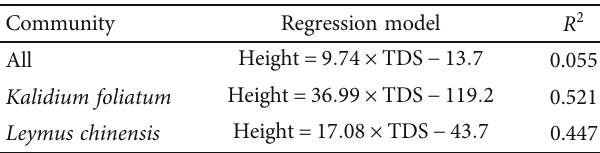
Table 3: Relationship between groundwater TDS and vegetation